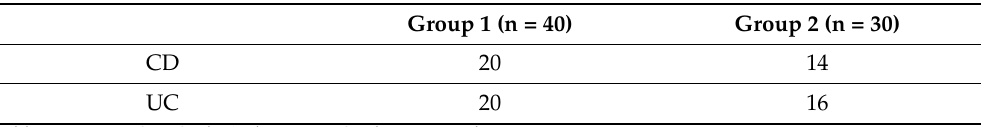
Table 2. Patients’ distribution among group 1 and 2 according to the osteoporosis definition by age and menopausal state.